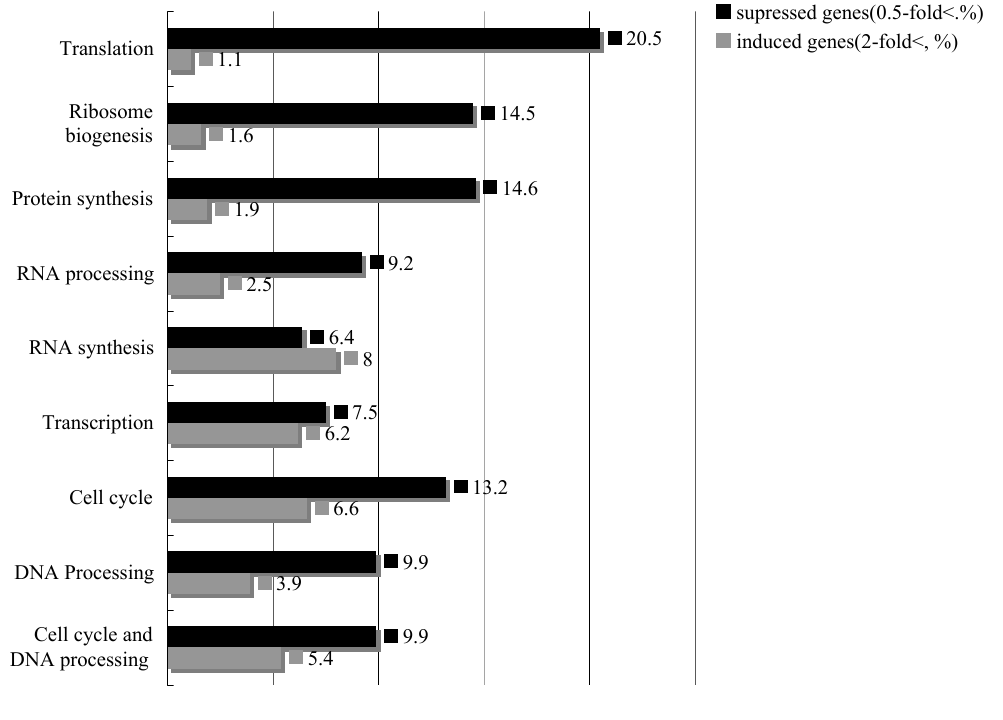
Figure 4. Sub-categories of cell cycle, DNA processing, transcription and protein